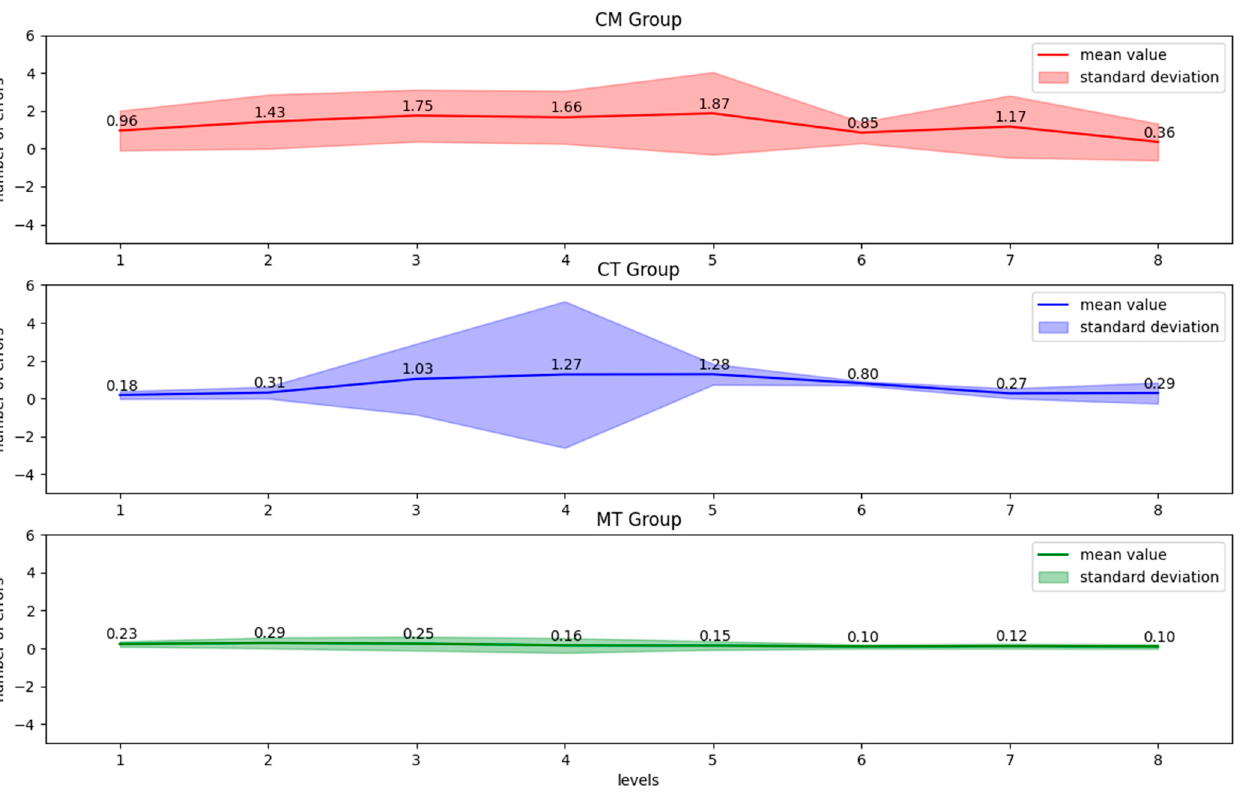
Figure 3. Average Number of Errors for each difficulty level in all training groups: the top chart—dual-task cognitive-motor group, the middle chart—single training cognitive group, the bottom chart—single training motor group. Table 4. Orientation and planning time and the number of errors comparison during the whole